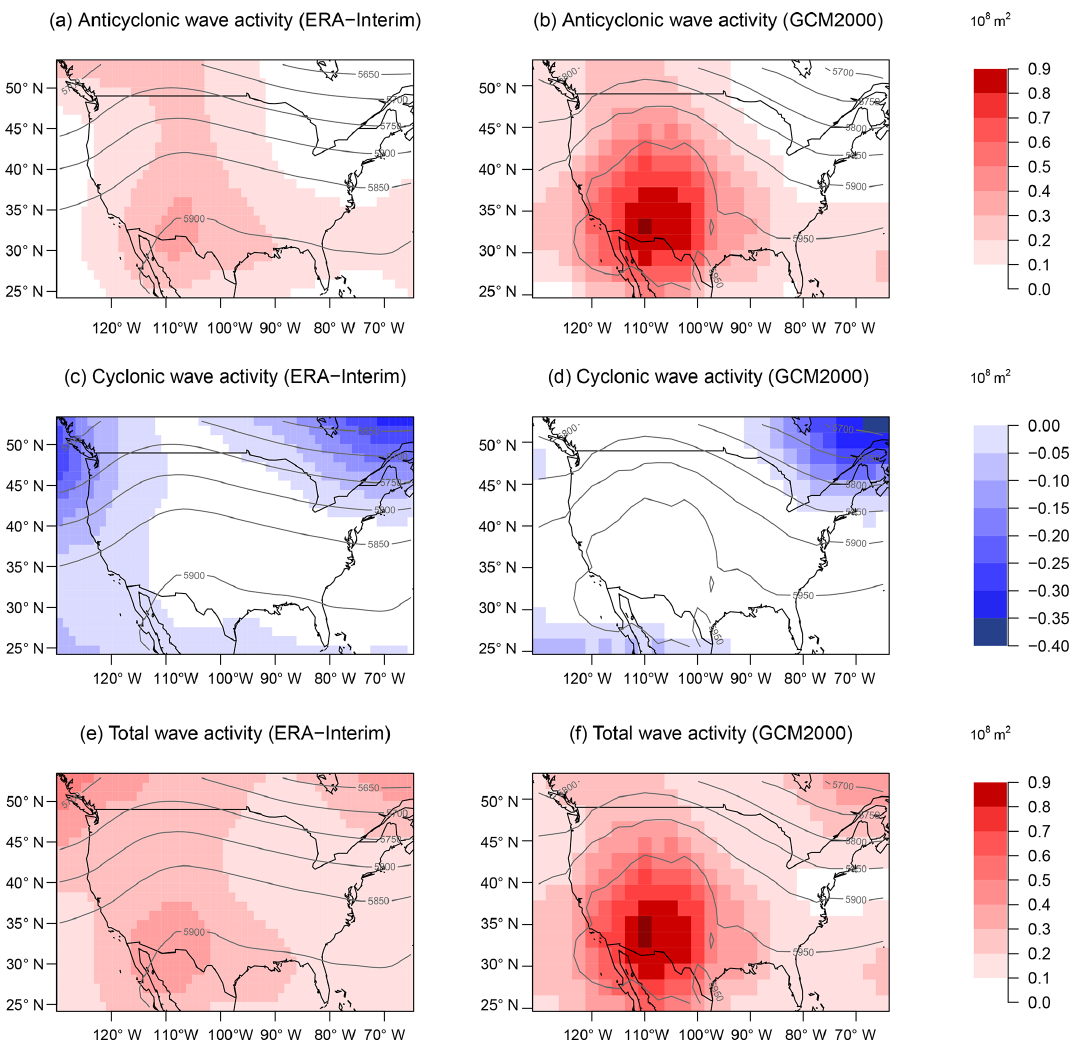
Figure 2. JJA climatology of daily averaged wave activity in color shades (10 8 m 2 ). Anticyclonic local wave activity (a) , cyclonic local wave activity (c) , and the magnitude of total local wave activity (e) with 500hPa geopotential height (contour, in m) for JJA 1979–2014 over the study region calculated from ERA-Interim reanalysis data. Climatology of anticyclonic local wave activity (b) , cyclonic local wave activity (d) , and the magnitude of total local wave activity (f) with 500hPa geopotential height (contour, in m) for JJA 2006–2025 over the study region calculated from the GCM2000